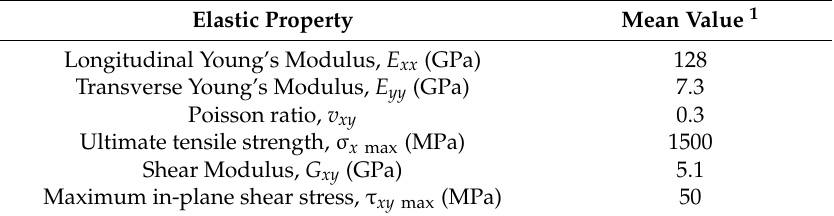
Table 5. Mechanical properties of IM7/EPOLAM 2019 CFRP used in aileron main beam.